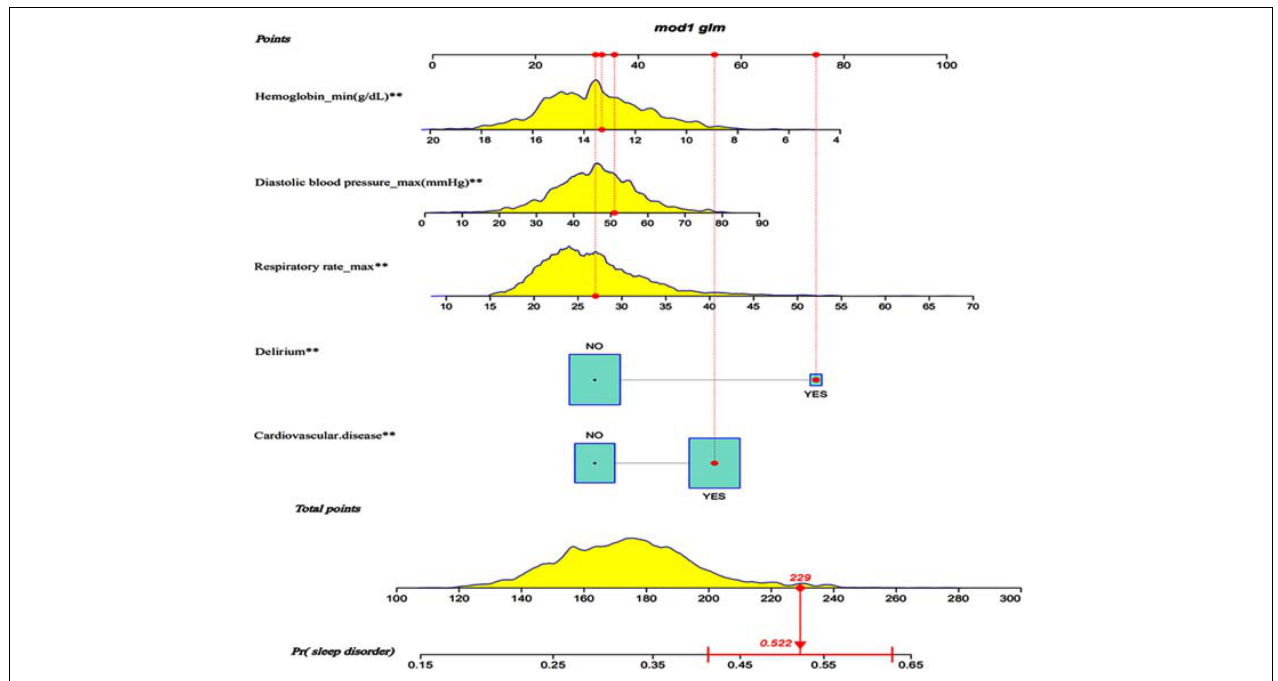
FIGURE 2 | Visualization nomogram to predict the occurrence of sleep disorders. Fist a standard line marked with 0–100 points is drawn from the points axis. Then each of five predictors (Diastolic blood pressure, hemoglobin, respiratory rate, cardiovascular disease and delirium) corresponds to a parameter value by drawing a visualization line graph from the point axis. Finally, a line from the total-points axis, which is the sum of the points for each of the five predictors in the range of 100 to 300, is below the last variable point axis. In addition, a probability line for predicting sleep disorders ranging from 0.15 to 0.65 is at the bottom of the nomogram.